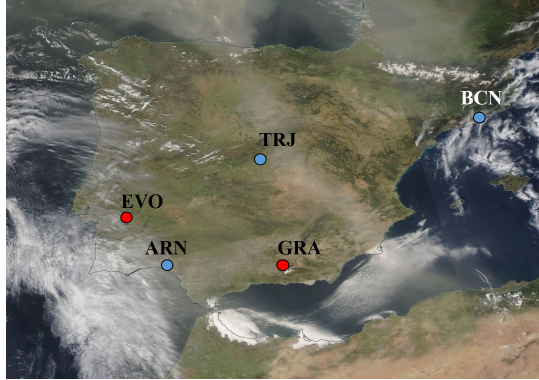
Figure 1. MODIS image of the corrected reflectance over the Iberian Peninsula on 31 March 2021. The five Iberian lidar stations are marked with a red dot (Raman lidar, RL) and blue dot (polarized micro-pulse lidar, P-MPL) (from NE to SW in the Iberian Penin- sula): Barcelona (BCN), Torrejón/Madrid (TRJ), Évora (EVO), Granada (GRA), and El Arenosillo/Huelva (ARN)